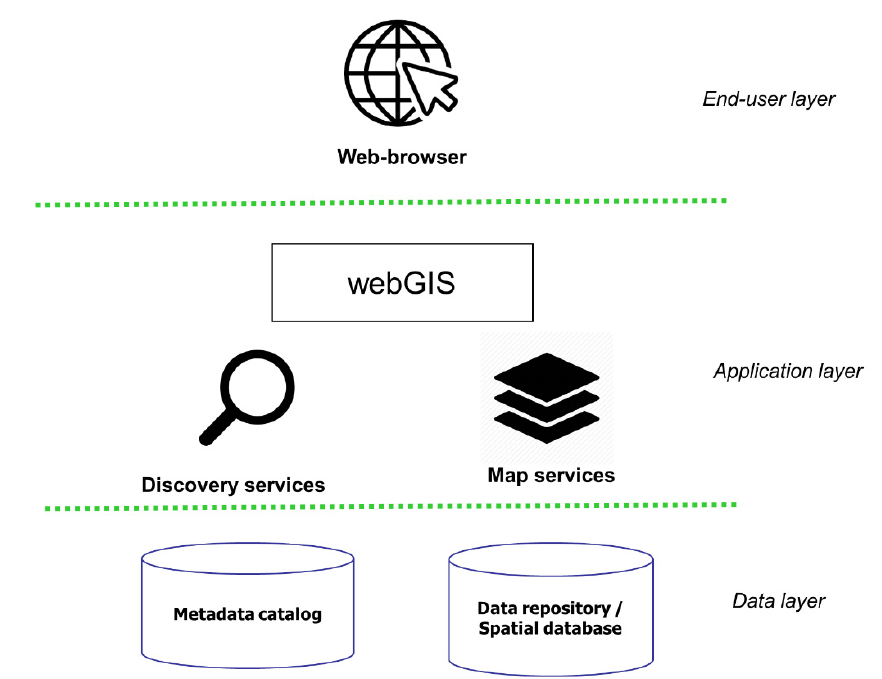
Figure 3. Generalized visualized architecture of an SDI. It integrates the Data layer, that consists of the infrastructure for storing data and metadata, Application layer, where the processing takes place and acts a medium between the user and the data, and End-user layer, the interface for interacting with the application layer and visualizing information.